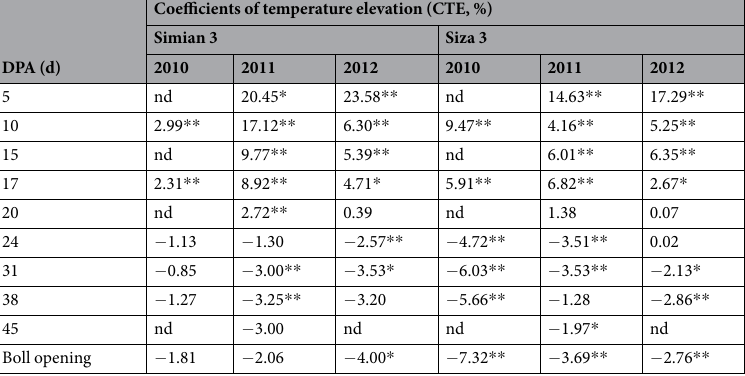
Table 4. Coefficients of temperature elevation (CTE, %) of cotton fiber length during fiber elongation, from 2010 to 2012. CTE, coefficient of temperature elevation was calculated by “(Temperature elevation − Control)/ Control × 100%”; * and ** represent significant difference at 0.01 and 0.05 probability levels, respectively, between two temperature regions,